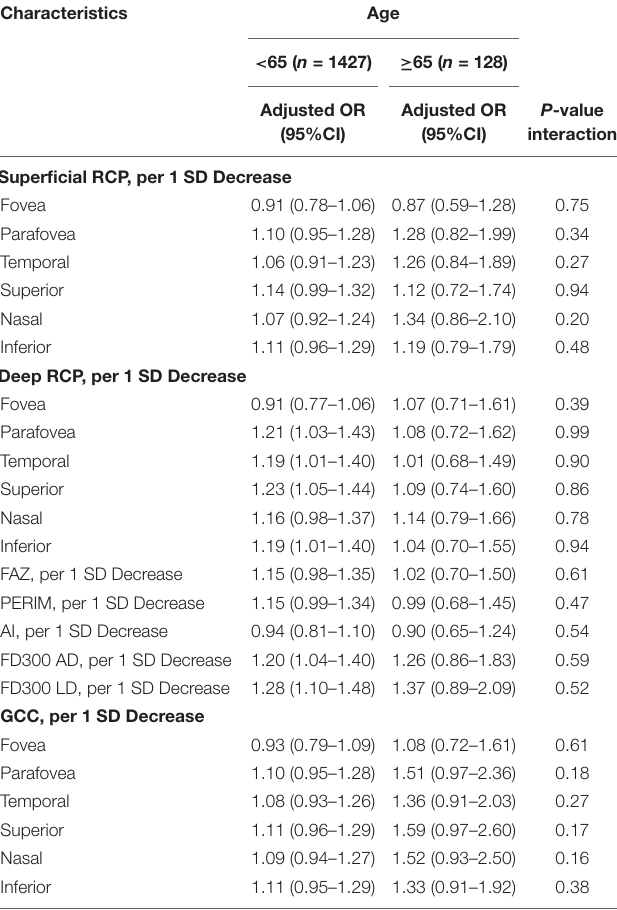
TABLE 5 | Subgroup analyses of association of RCP and GCC with cognitive impairment based on age. Characteristics